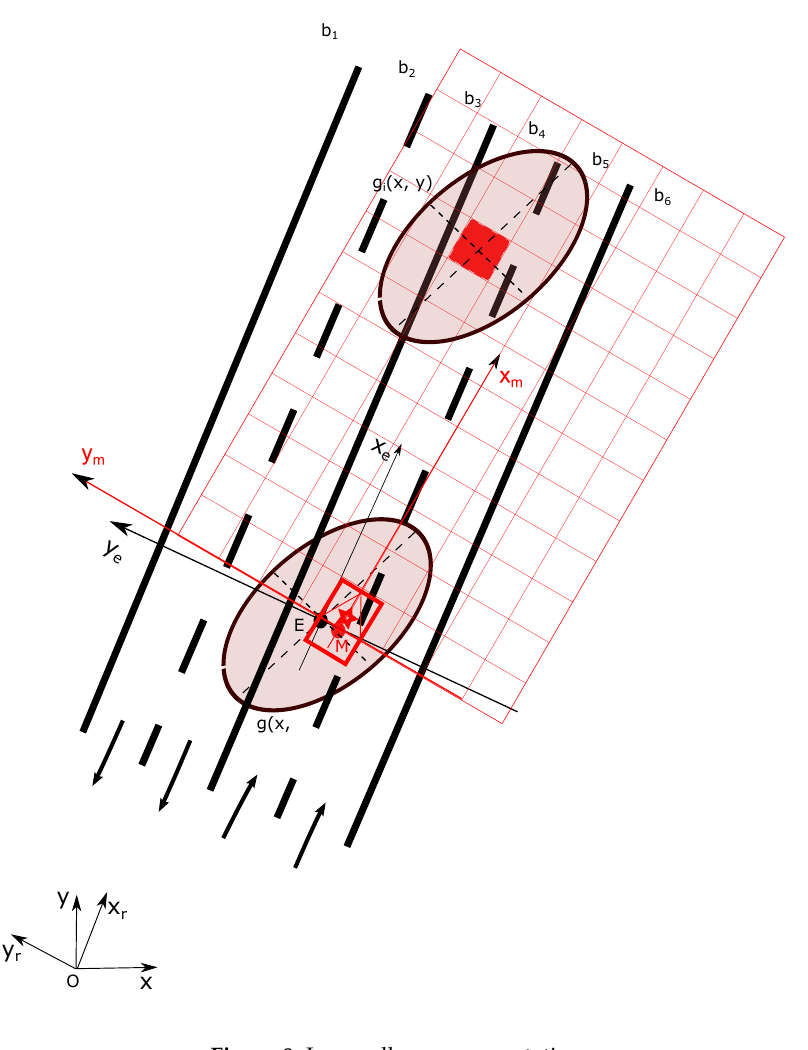
Figure 8. Lane cell mass